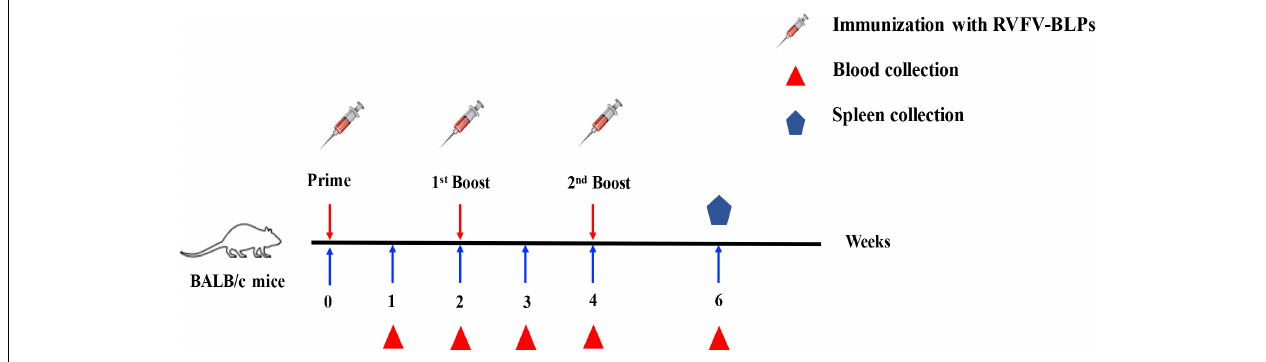
FIGURE 5 | Immunization schedule. BALB/c mice were immunized intramuscularly with different doses of RVFV-BLPs and boosted two times with the same amount on days 14 and 28.